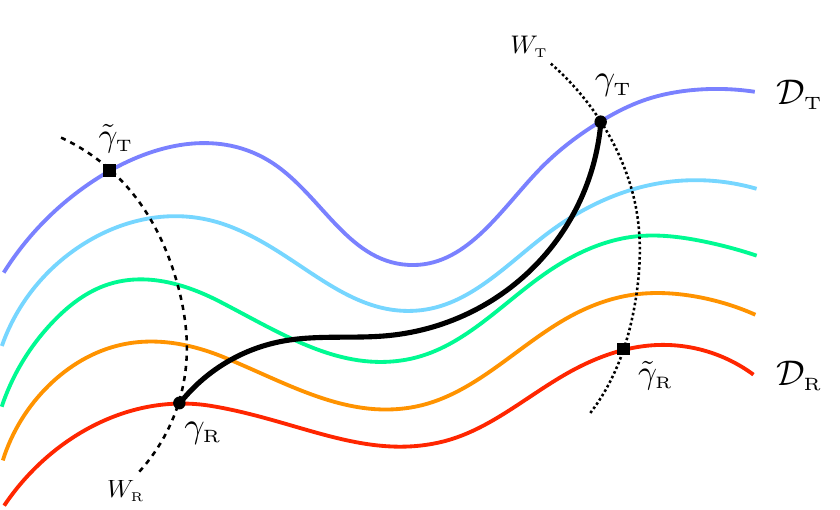
path and the W path that pass R T and ˜ γ have been defined R T